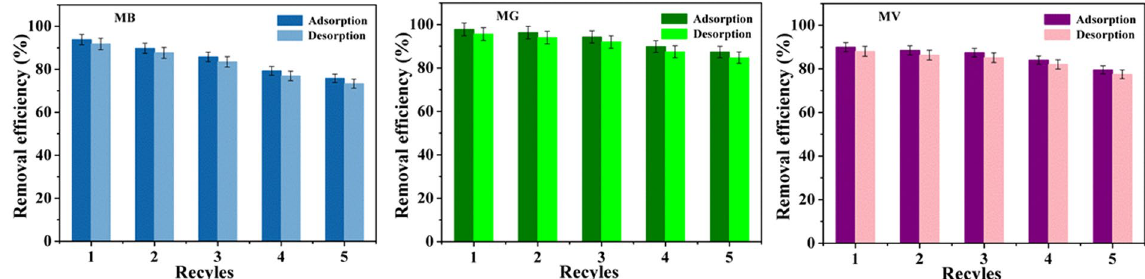
Figure 8. Adsorption-desorption recycles of MB ( m = 5 mg, C 0 = 40 mg L − 1 , V = 10 mL, pH = 6, contact time was 10 min, temperature was 298 K), MG ( m = 5 mg, C 0 = 40 mg L − 1 , V = 10 mL, pH = 6, contact time was 120 min, temperature was 298 K) and MV ( m = 4 mg, C 0 = 40 mg L − 1 , V = 10 mL, pH = 6, contact time was 120 min, temperature was 298 K). Error bar = SD (n =